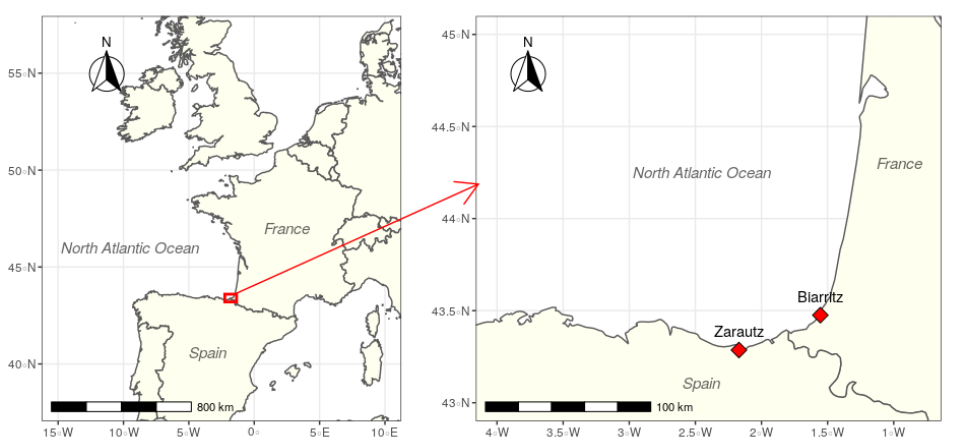
Figure 2. Map showing the locations of the two study